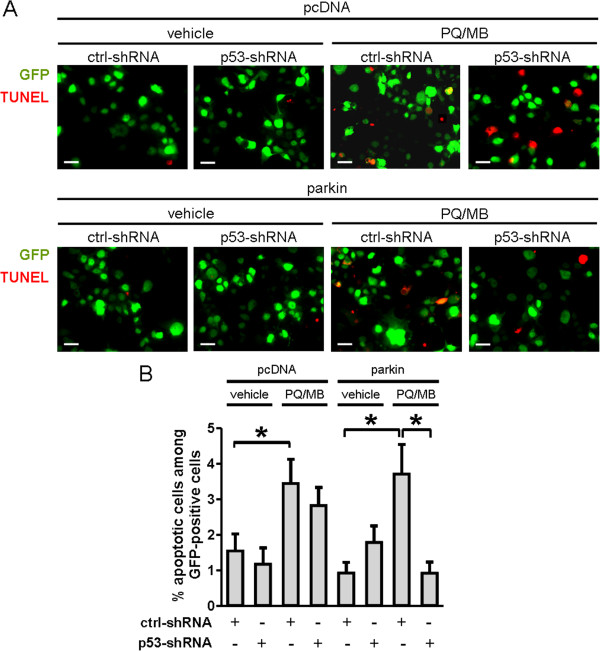
Role of p53 in herbicide/fungicide-induced apoptosis in SH-SY5Y cells overexpressing parkin. A, Histological images of cells transiently co-transfected with plasmids for pcDNA or parkin, together with shRNA vectors coexpressing GFP (green). Cells were exposed to a combination of 100 μM paraquat (PQ) and 10 μM maneb (MB) or vehicle for 6 h, fixed, and subjected to TUNEL staining (red). Scale bar: 20 μm. B, Percentage of TUNEL-positive cells among GFP-positive cells under the indicated conditions. Values are mean + SEM of 183–656 cells per condition performed in triplicate experiments; * p < 0.05.